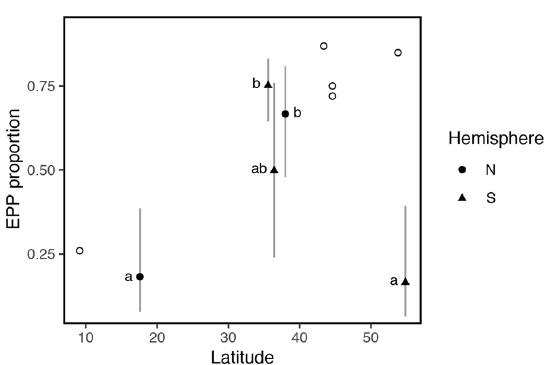
Figure 3. Latitudinal variation in the proportion of nests with extra-pair offspring in each population. X axis: absolute latitude; Y axis: proportion of females in the population with at least one extra-pair offspring in their nest (EPP proportion). Open symbols represent population proportions taken from previously published studies; filled symbols represent population proportions calculated by the model for the data used in this study (154 nests from 5 locations). Lines correspond to the 95% confidence intervals for each proportion calculated following Wilson’s method used for binomial variables with small sample sizes 58 . Populations from the North hemisphere are represented by circles, populations from the South hemisphere are represented by triangles. Symbols with different letters have statistically different proportion